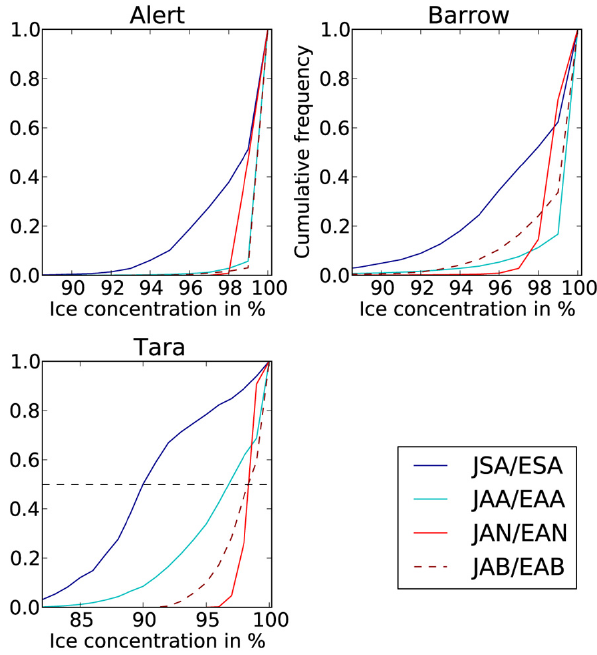
Fig. 6. Cumulative frequency distribution of ice concentrations along the trajectories (ERA and JRA combined) for different ice concentration data sets for Alert, Barrow and